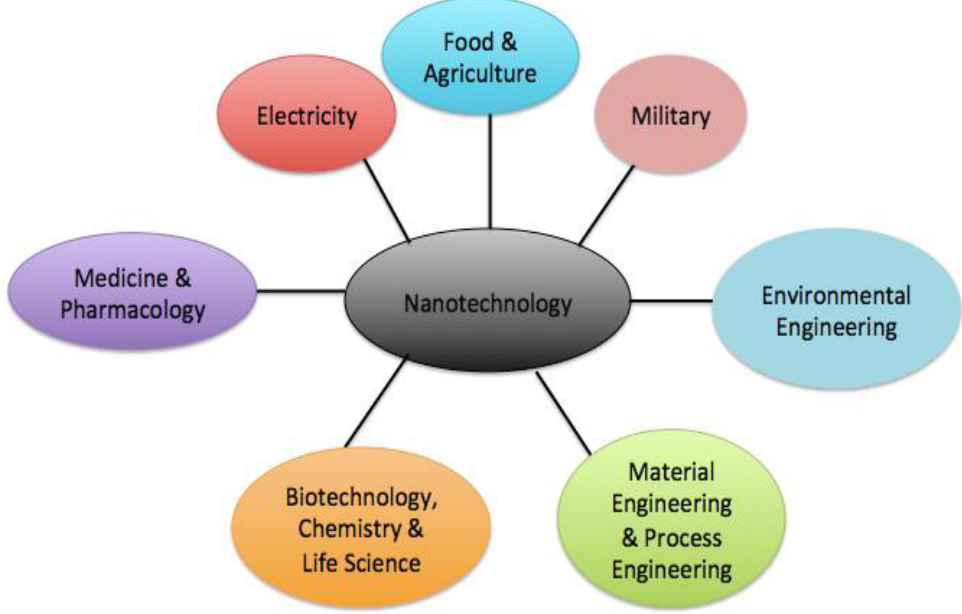
Figure 1. Application areas of nanotechnology. [1].